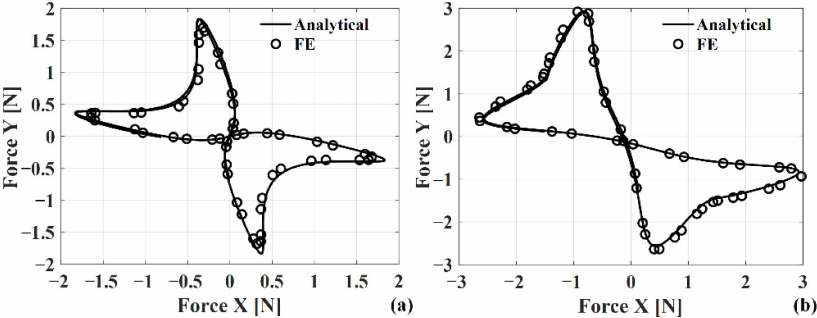
Figure 8. UMFs due to ( a ) no-load and ( b ) rated load conditions.